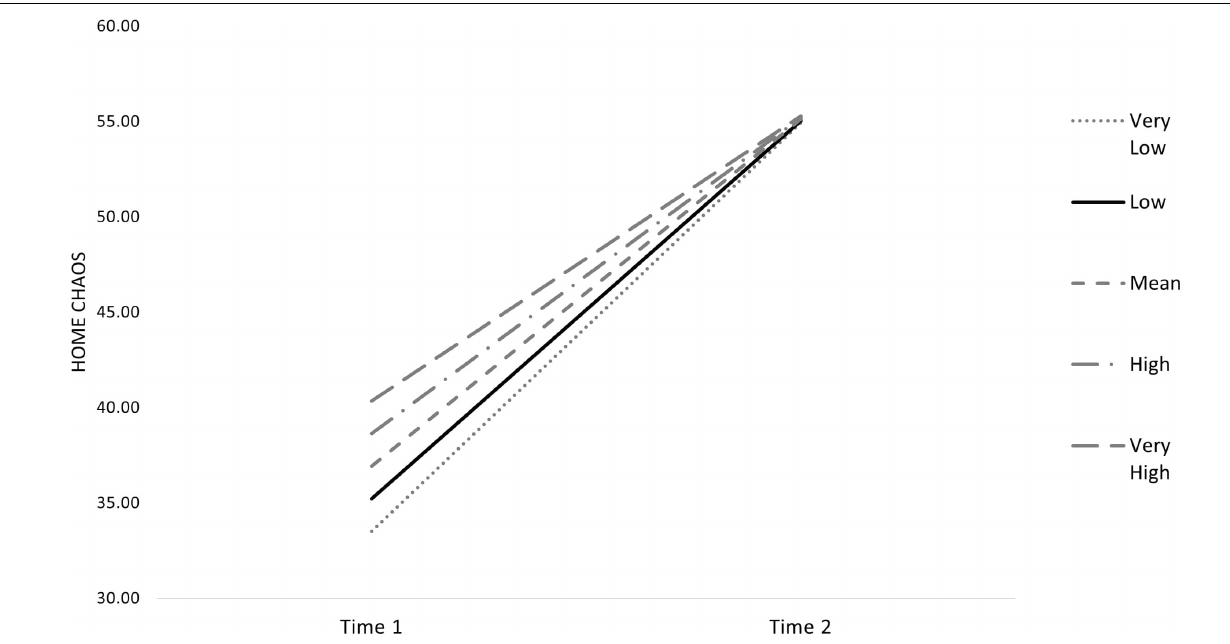
Supplementary Figure 1 | Recruitment Flyer. Supplementary Table 1 | Checklist for Reporting Results of Internet E-Surveys